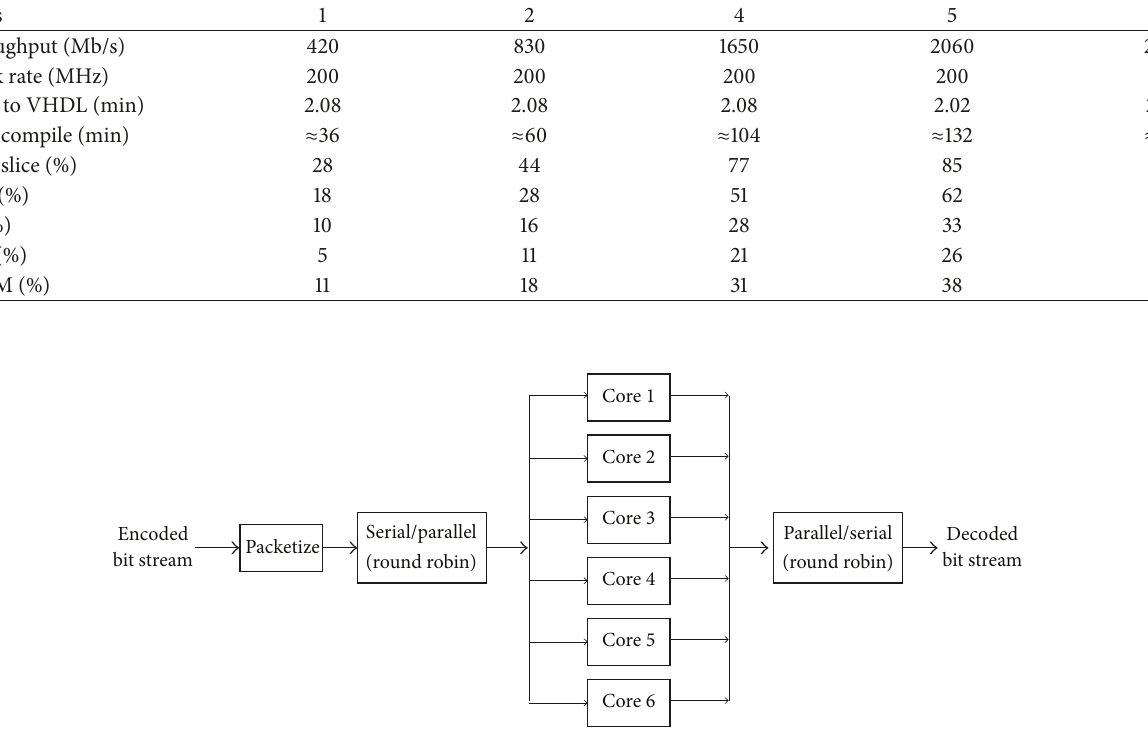
Figure 11: High-level system schematic illustrating the fixed latency, parallel processing of the decoder